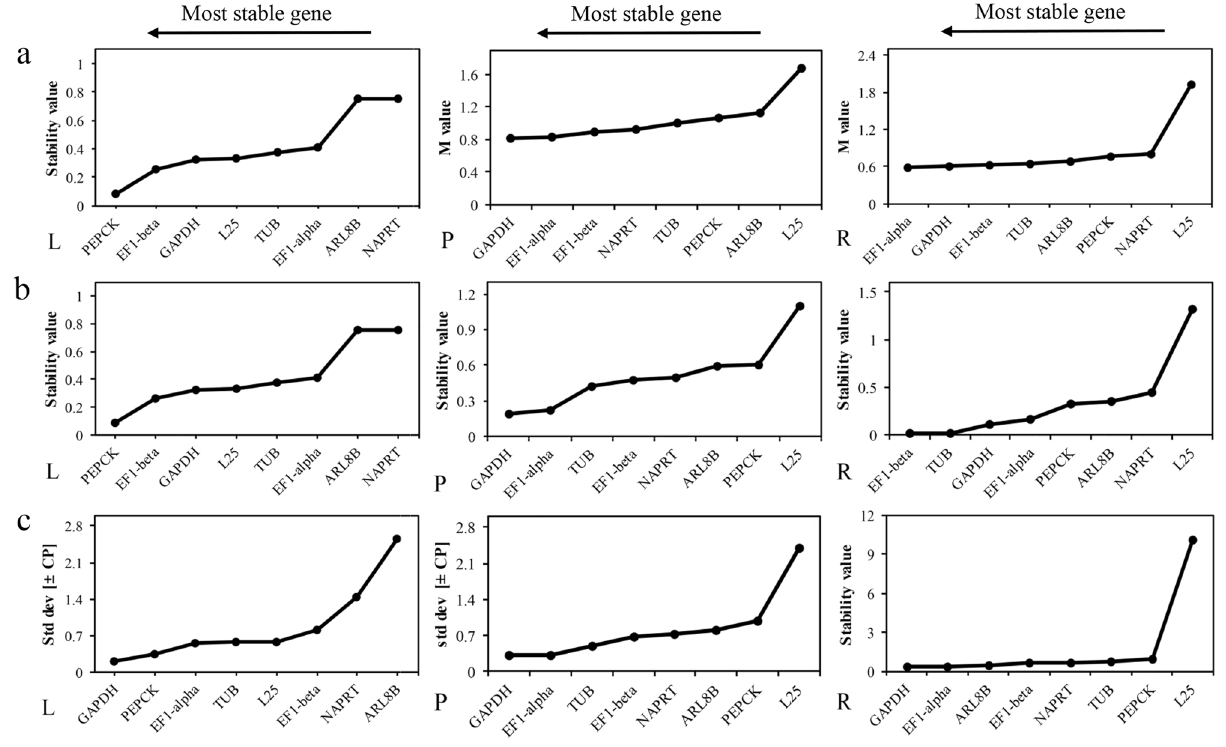
Figure 5. Expression stability of eight candidate reference genes in Dt of P. ternata as calculated by geNorm ( a ), NormFinder ( b ) and Bestkeeper ( c ). L = Leaf; P = Petiole; R = Root.